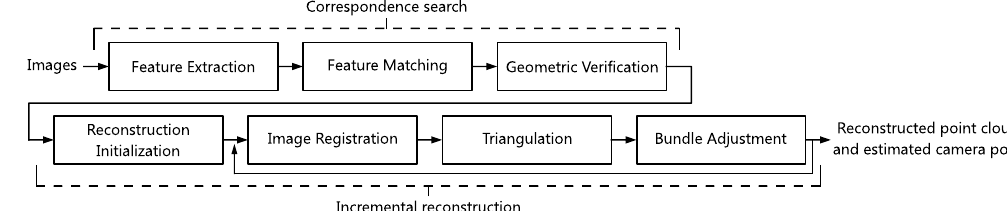
Figure 2. Incremental Structure from Motion